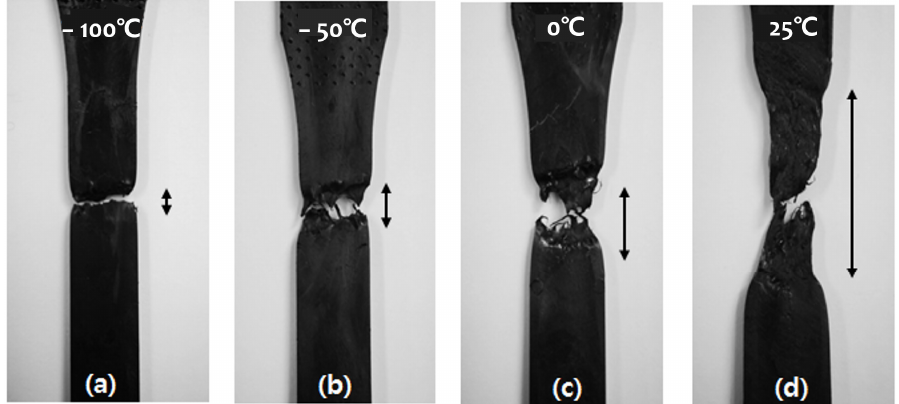
Figure 4. Failure types of the PVDF specimens depending on temperatures: ( a ) − 100 °C, ( b ) − 50 °C, ( c ) 0 °C, and ( d ) 25 °C.